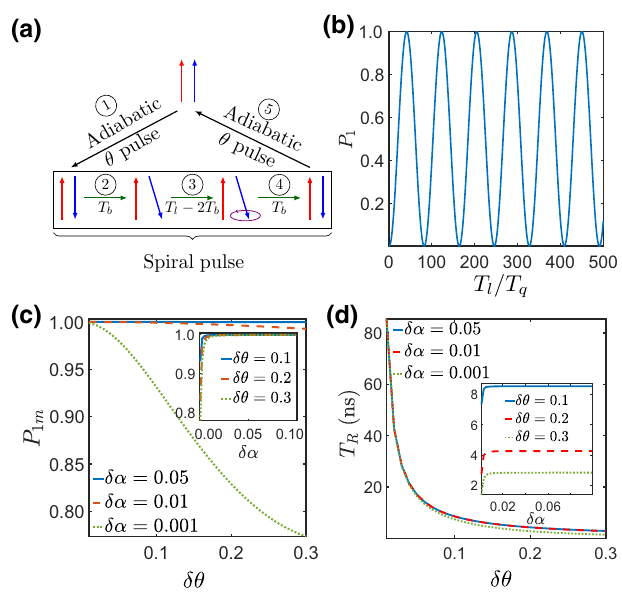
FIG. 3. (a) The pulse sequence proposal for coherent manip- ulation of the YSR qubit: the right spin (blue) is first rotated adiabatically from θ = 0 to θ = π in time T a , then driven into resonant precession with the qubit for a time T l , after which it is rotated back adiabatically to its original orientation. The qubit can also be fully operated in the antiparallel configuration. (b) The Rabi oscillations encoded in the probability of state | 1 (cid:4) being occupied, P 1 ( T l ) = |(cid:16) 1 | ψ( T l ) (cid:4)| 2 , as a function of the pulse time T l for T a = 6 T q and T b = 0.6 T q . The other parameters are δθ = 0.1, α 1 = 1.15, α 2 = 1.1, R = 2.9, so that t h /δα = 0.34. (c) The amplitude of the Rabi oscillations, P 1 m , as a function of the angle deviation δθ (main) and δα (inset). Here, t h /δα = 17, 1.7, and 0.34 for δα = 0.001, 0.01, and 0.05, consistent with P 1 m ∼ 1 for t h (cid:6) δα on a wide range of δθ values. (d) The Rabi oscillation period, T R , as a function of δθ (main) and δα (inset) for different values of δα and δθ , respectively. The same conclusions as in (c) apply. All plots are obtained using k F =